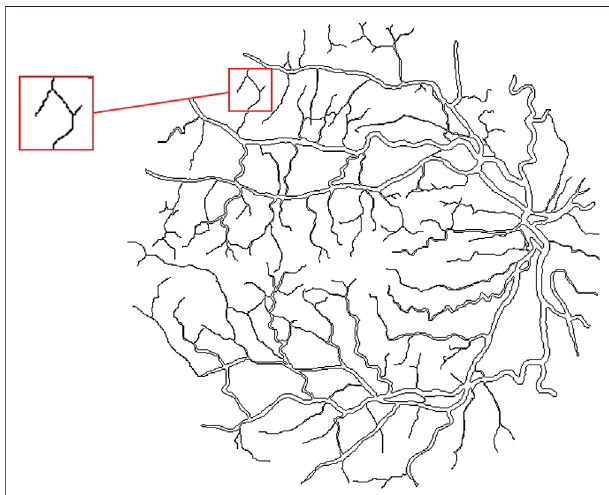
FIGURE 6 | Outline of vessel. An exemplar of non-deletable points is shown in the red box: the vessel in this segment is only about two pixelswide. If removing the outline of this segment, the corresponding vessel in this segment will